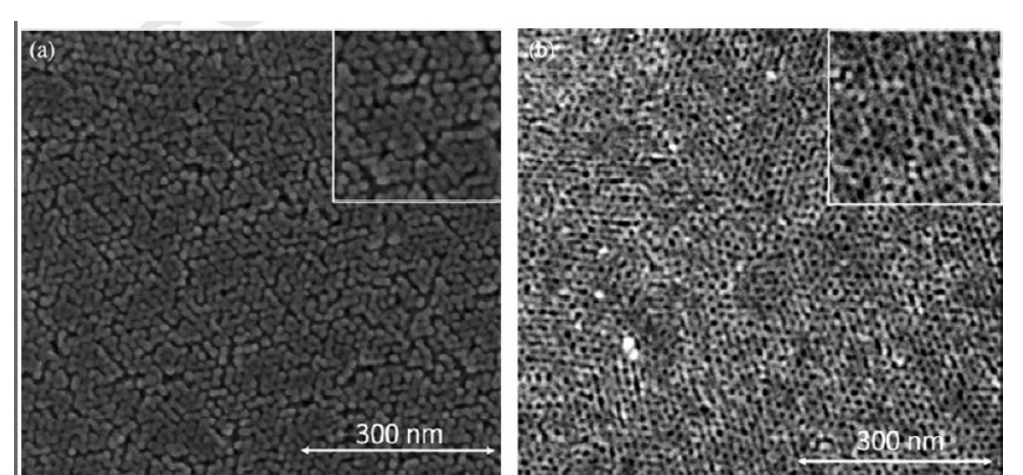
Figure 9. SEM image of ( a ) pillar-MTTFs, and ( b ) tube-MTTFs Reprinted from ref [67], Copyright (2012), with permission from